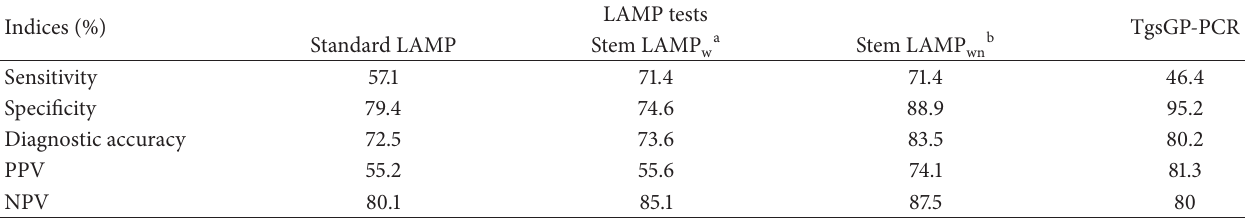
Table 2: The diagnostic performance of TgsGP LAMP test formats and PCR using archived reference